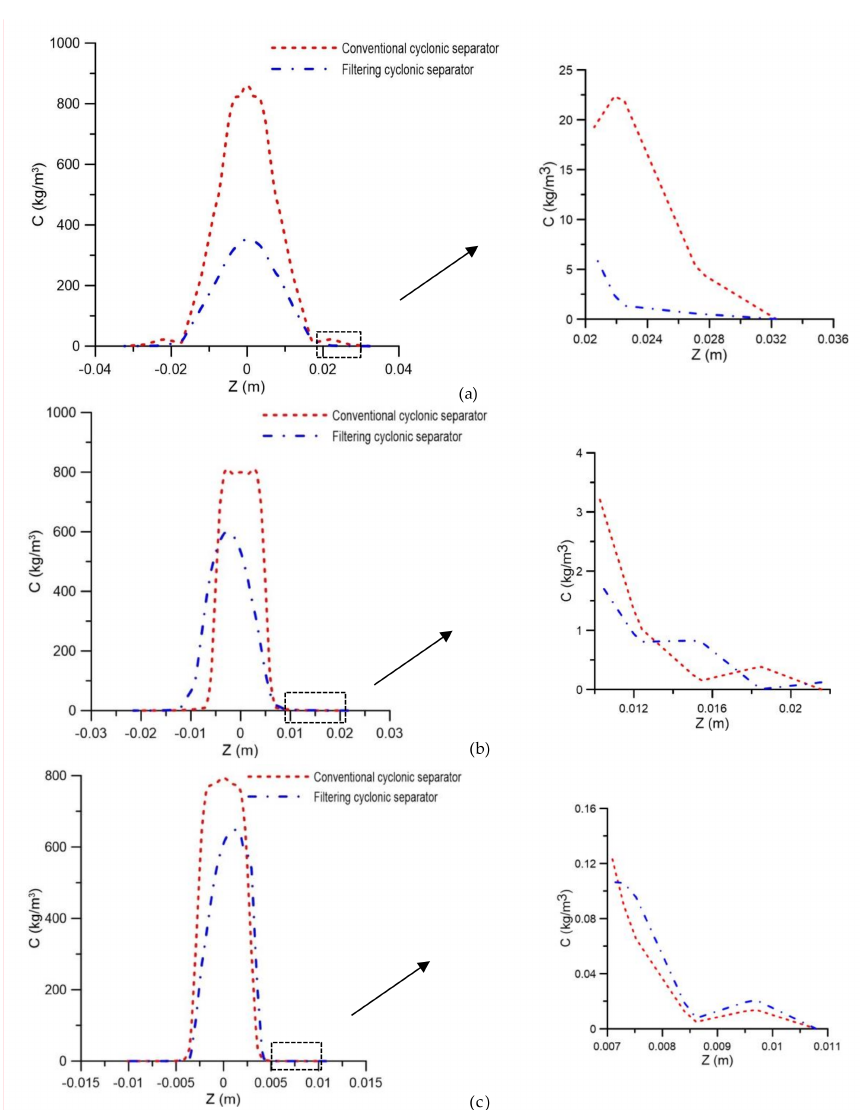
Figure 12. Oil concentration profile in conventional and filtering hydrocyclones at the positions ( a ) y = 0.15 m, ( b ) y = 0.45 m and ( c ) y = 0.75